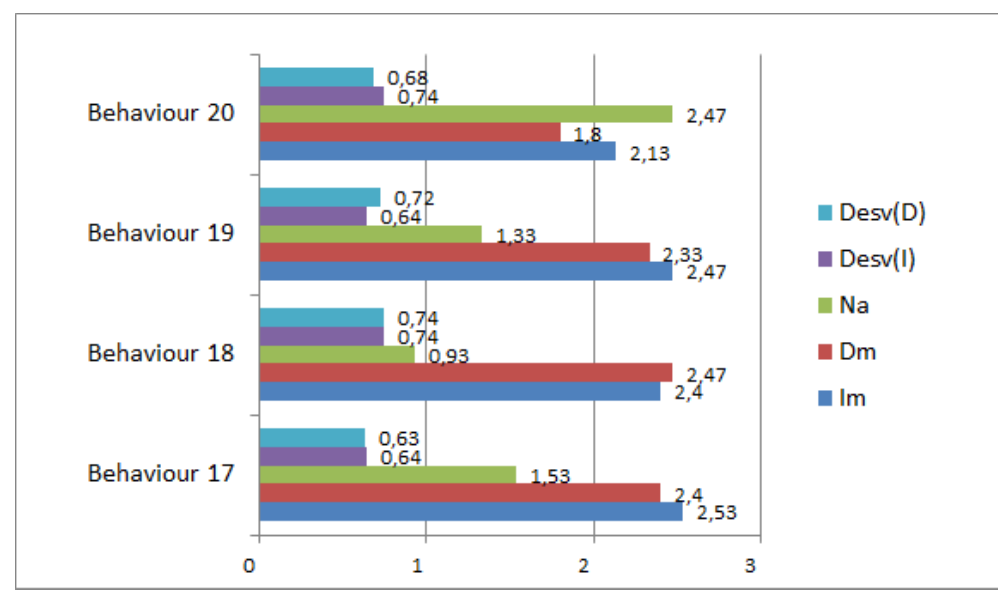
Figure 4. Productive